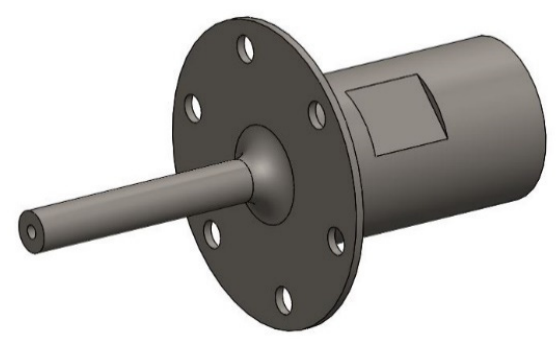
Figure 2. Two-stage ladder horn.